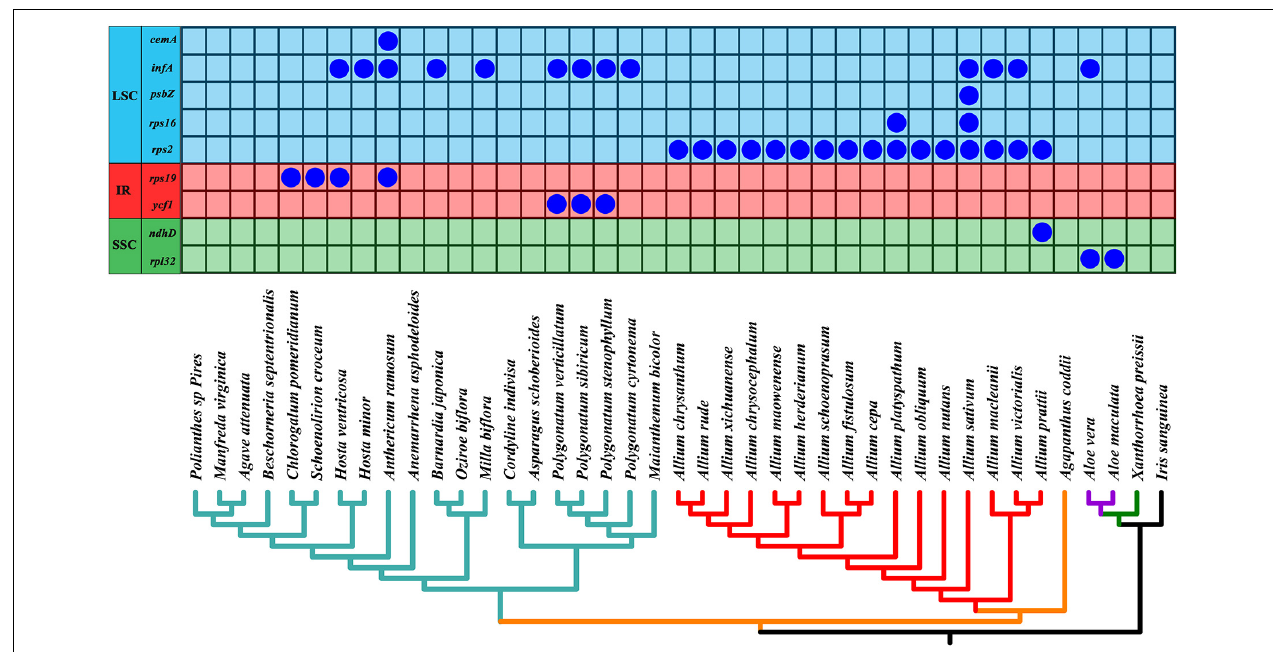
FIGURE 6 | Loss of chloroplast protein-coding genes in the phylogeny of all 41 taxa. Below is the phylogeny of all 41 species based on chloroplast genomes as shown in Figure 7 . Different chloroplast regions were indicated at the left side. Allioideae are shown on red branches. IR, inverted repeat; LSC, large single-copy region; SSC, small single-copy